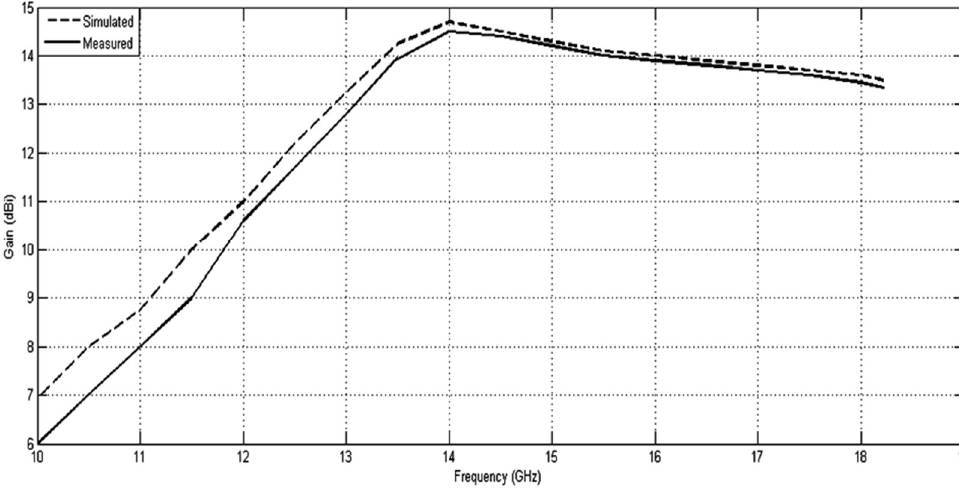
Figure 9 . Radiation angles for SIW LWA .